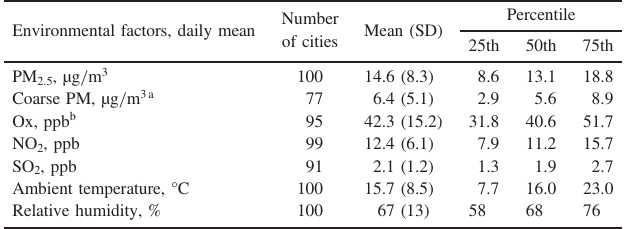
Table 1. Overall statistics of environmental factors in